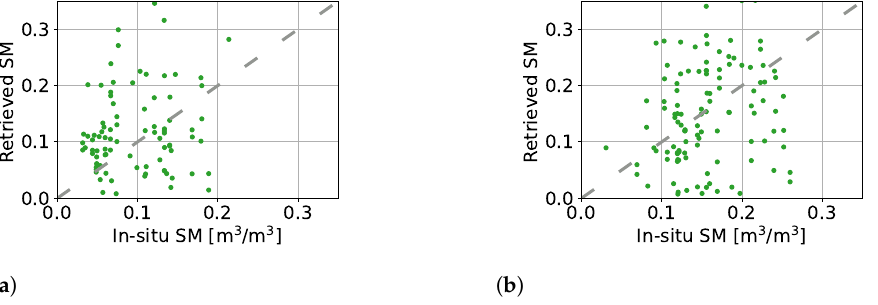
Figure 18. Soil moisture retrieval using the second scheme from DDMs close to Y8 compared to the averaged in situ soil moisture of Y5, Y7, and Y8 stations. SM denotes soil moisture. ( a ) Year 2019.